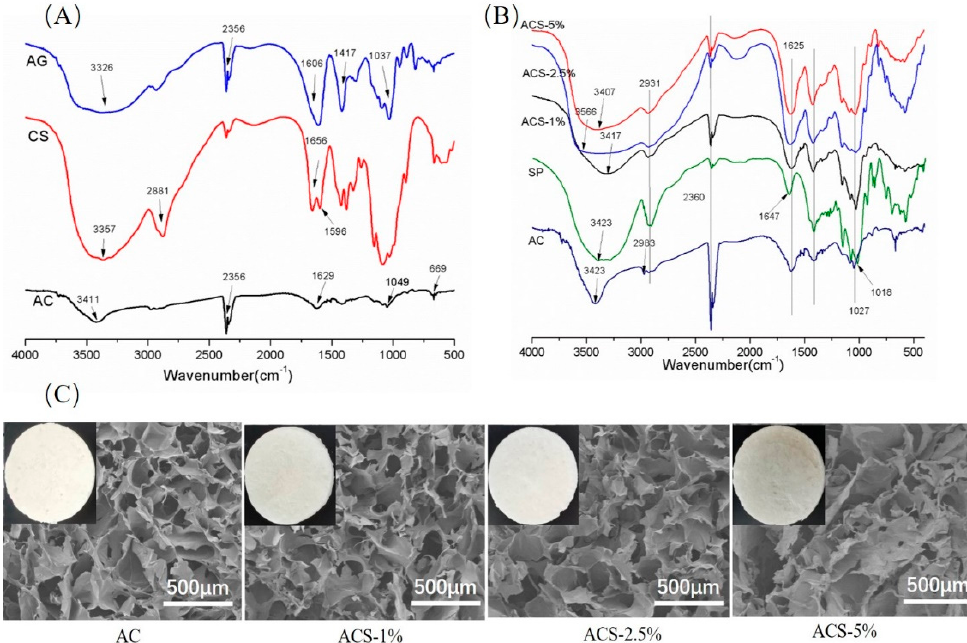
Figure 2. ( A ) FTIR spectra of AG, CS, and AC. ( B ) FTIR spectra of AC, SP, ACS—1%, ACS—2.5%, and ACS—5%. ( C ) Scanning electron micrographs of composite sponges; the insets in images are photographs of the corresponding composite sponges.